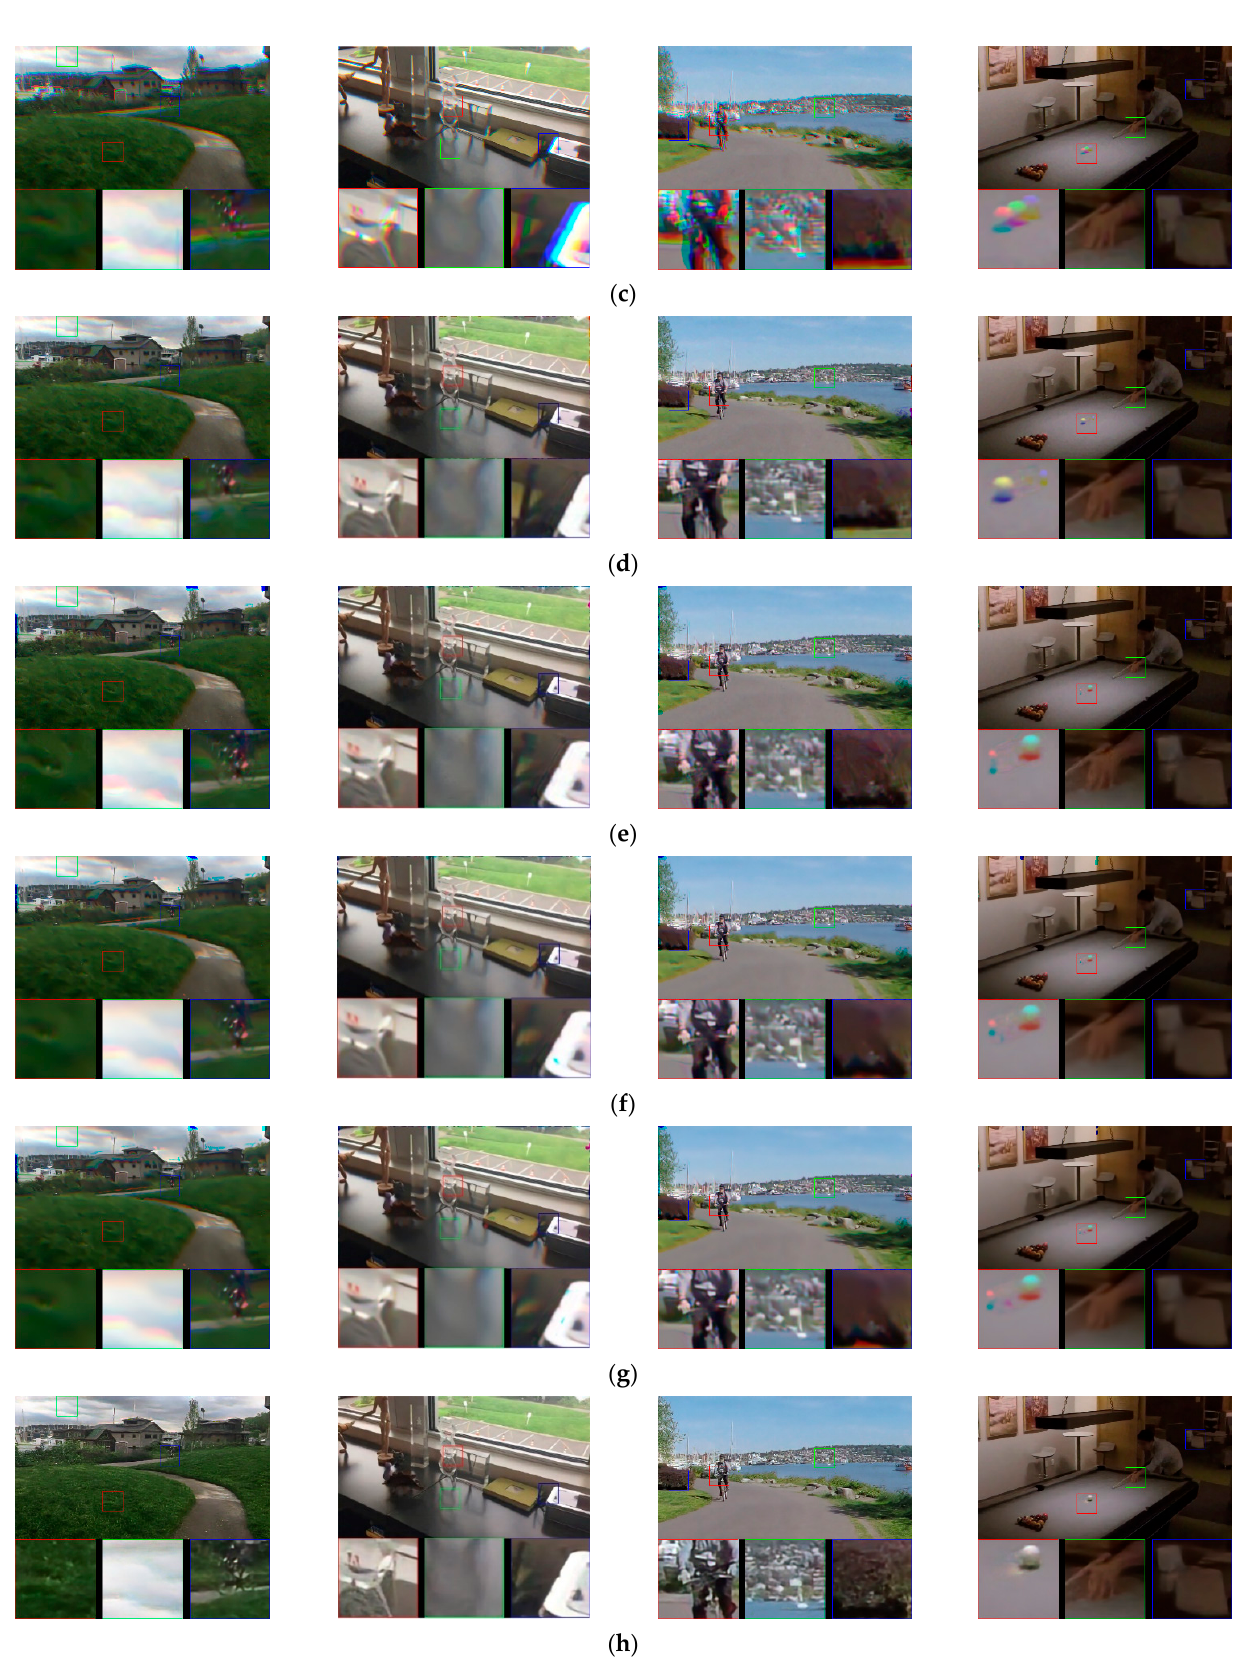
Figure 10. Denoising results on generated test set data: ( a ) input noisy image with color-channel motion artifacts; ( b ) ground truth; ( c ) CBM3D; ( d ) CBM3D + FE; ( e ) DnCNN + FE; ( f ) fDnCNN + FE; ( g ) FFDNet + FE; ( h ) proposed DKPNN.